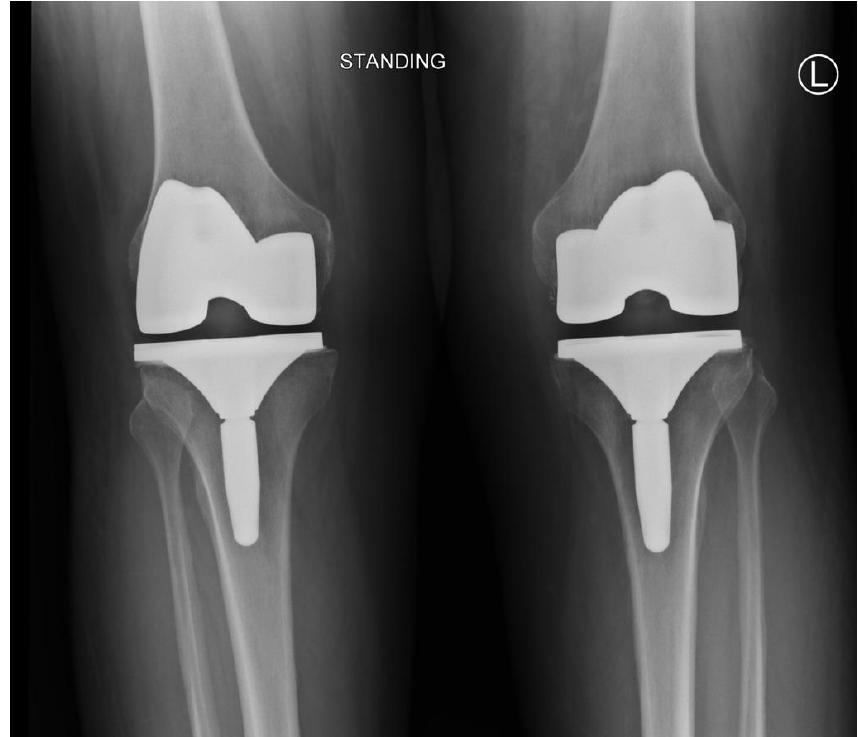
Figure 3. The patient showing disruptive extensor mechanism by right positive leg-raising test. The patient is trying to lift the right leg; the thigh portion is lifting from the bed surface, but the heel is not lifting due to a complete rupture in the quadriceps muscle.